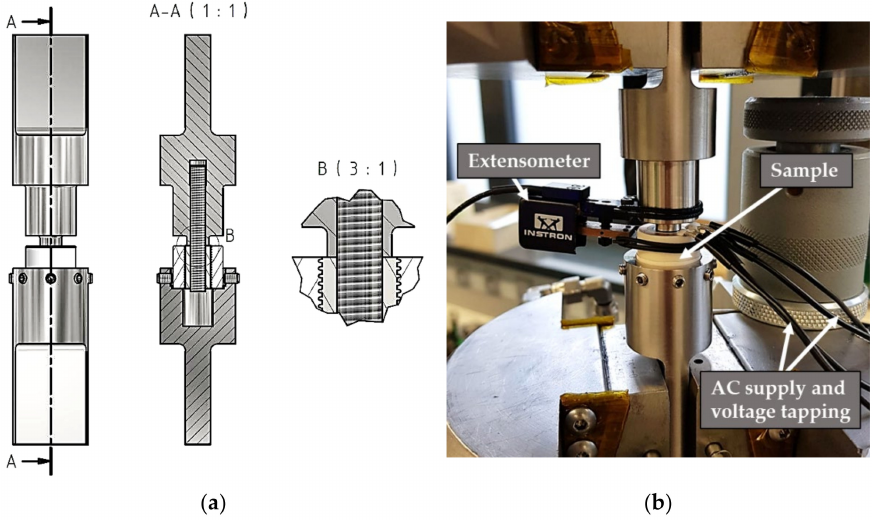
Figure 6. ( a ) Technical drawing of the clamping device for samples with cross-sectional view (A-A) and detailed view (B), and ( b ) test setup for fatigue tests using the servo-hydraulic testing